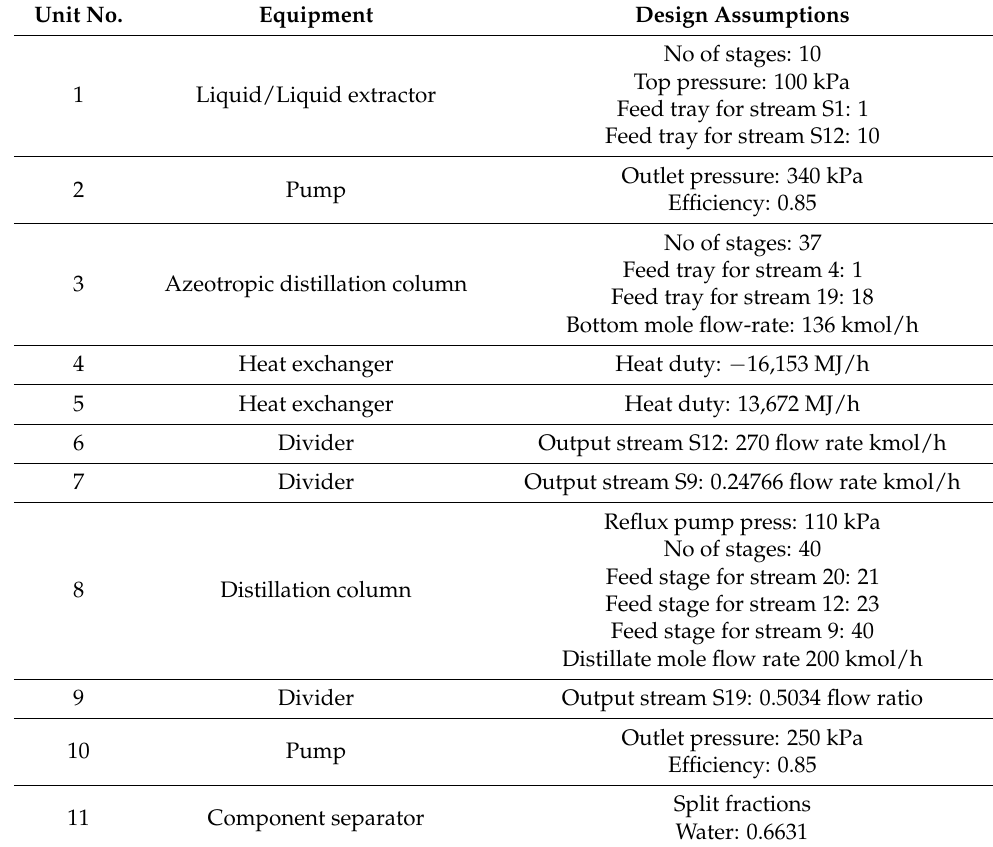
Table 5. Design assumptions for the main units for case 5. Unit